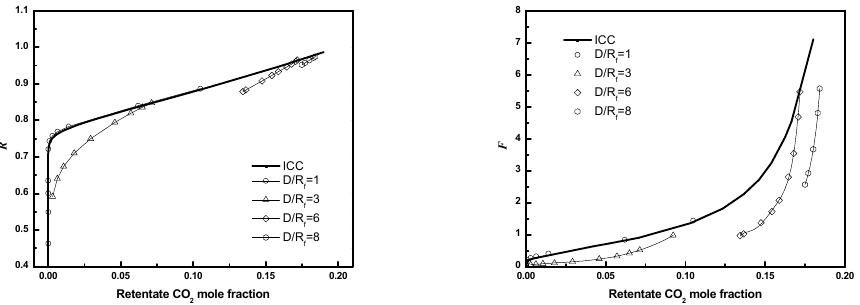
Figure 16. R or F as a function of CO 2 mole fraction for module with different D/R f (3-D, N = 25, φ = 0.6).